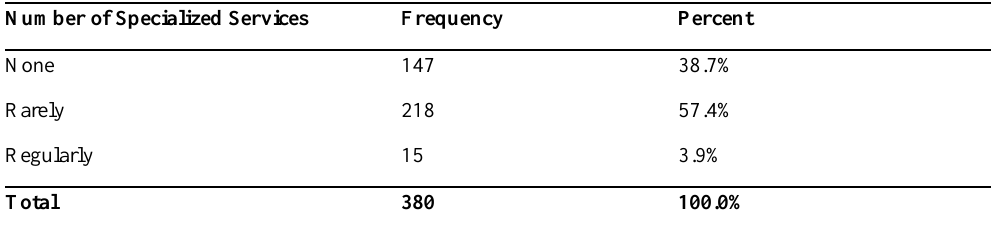
Table 3: Distribution of Respondents based on Access to Specialized Services